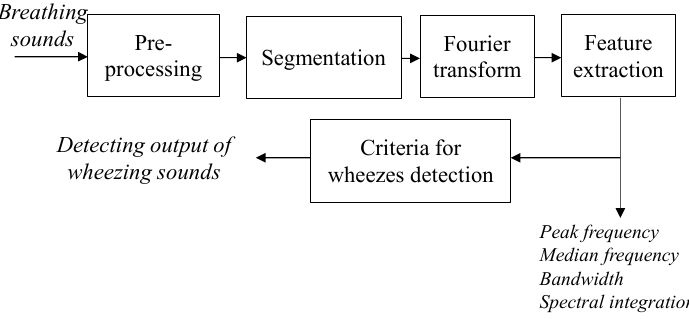
Figure 4. Flowchart of breathing sound analysis algorithm.